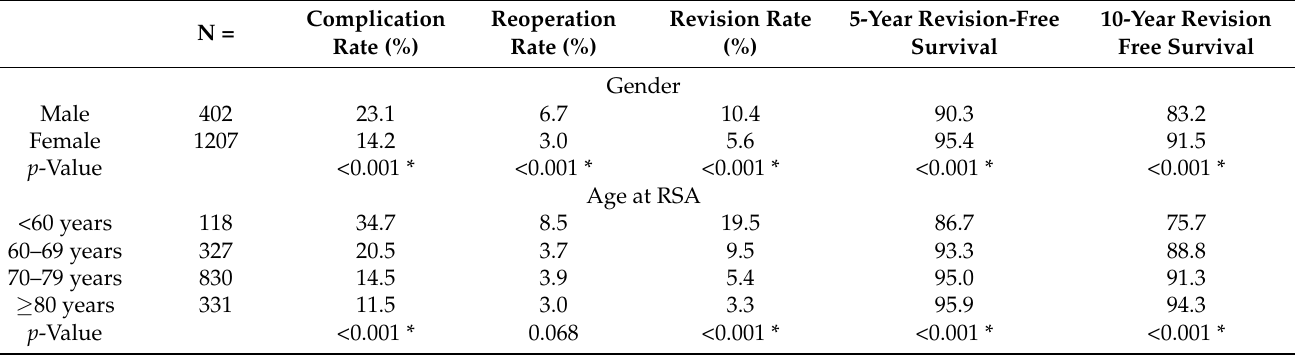
Table 4. Complications and revision surgeries according to gender and age.